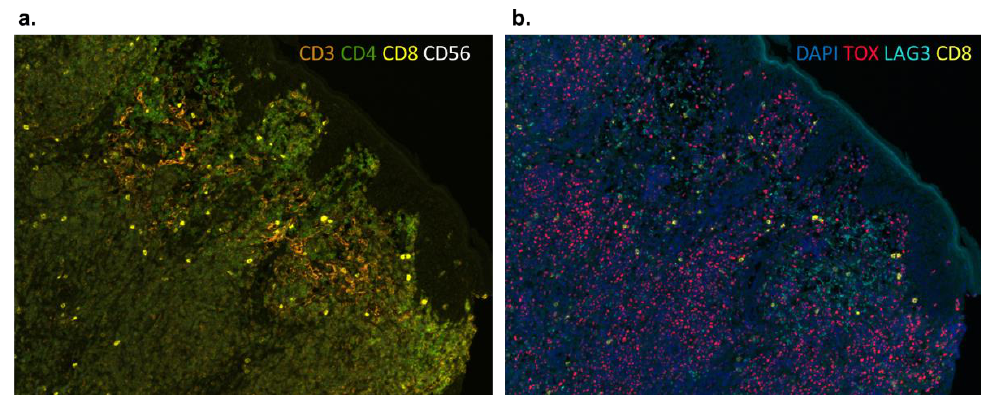
Figure 3. LAG3 expression in the skin of a patient with Sezary syndrome. ( a ) Dense lymphocytic infiltrate of the skin by CD3 dim CD4+ Sezary cells. Note CD4+ tumor-infiltrating lymphocytes in the top portion of the reticular dermis. ( b ) Moderate expression of LAG3 on CD4+ and CD8+ tumor-infiltrating lymphocytes but not on TOX+ Sezary cells.